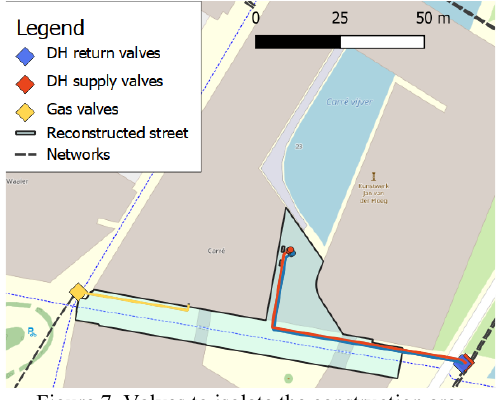
Figure 7. Valves to isolate the construction